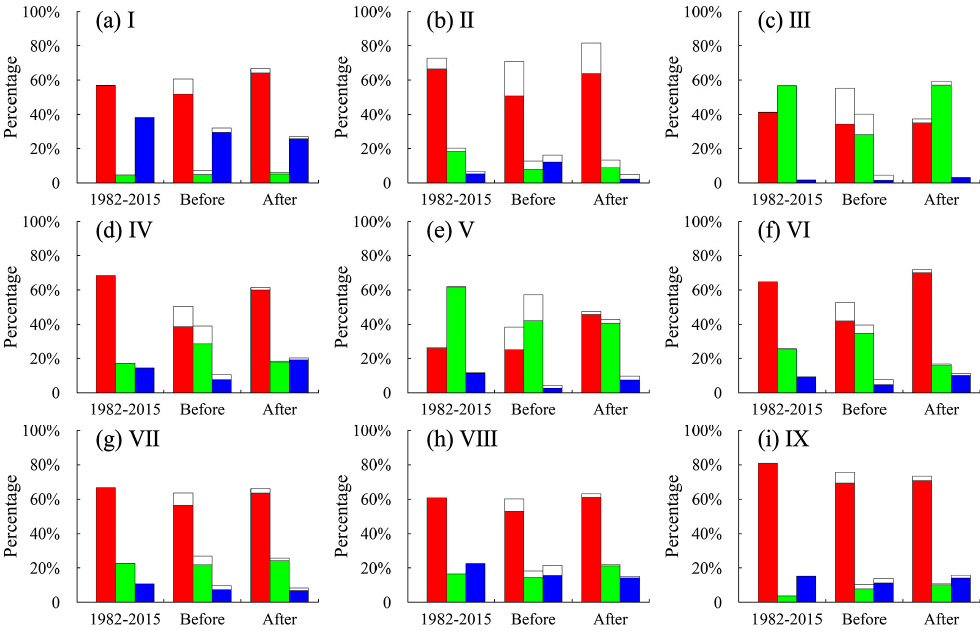
Figure A1. The NDVI fitting results of three equations, including HANTS (red lines and numbers), Polyfit (green lines and numbers), and Double logistic (red lines and numbers). ( a – i ) represent sub- regions I – IX, respectively. The upper-left panels are corresponding NDVI ratio changes and EOS with HANTS and Polyfit fitting methods. The upper-right numbers are RMESs for three fitting methods.